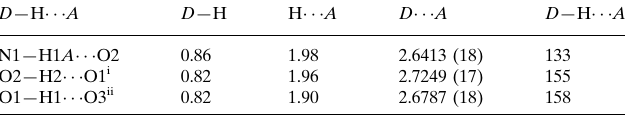
Hydrogen-bond geometry (A˚ , (cid:2)